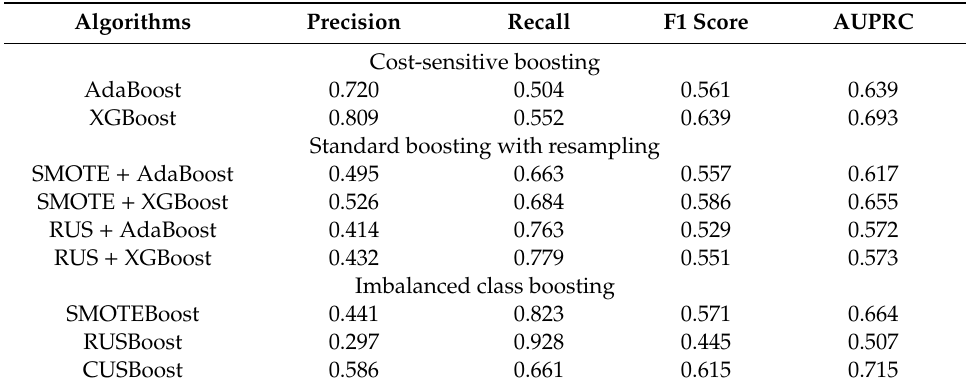
Table 3. The performance of boosting algorithms (Dataset 1).